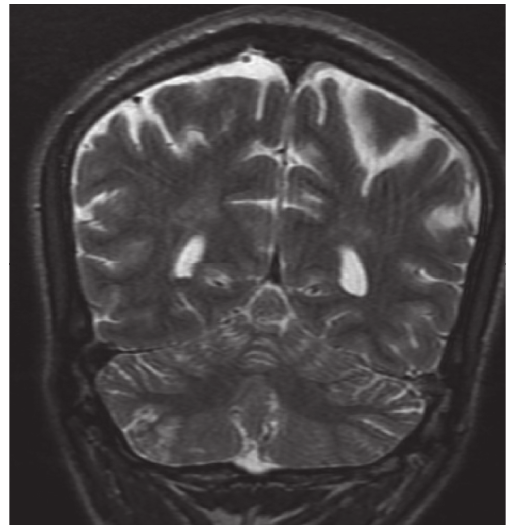
Figure 2: Coronal view of MRI brain showing the right cerebellar